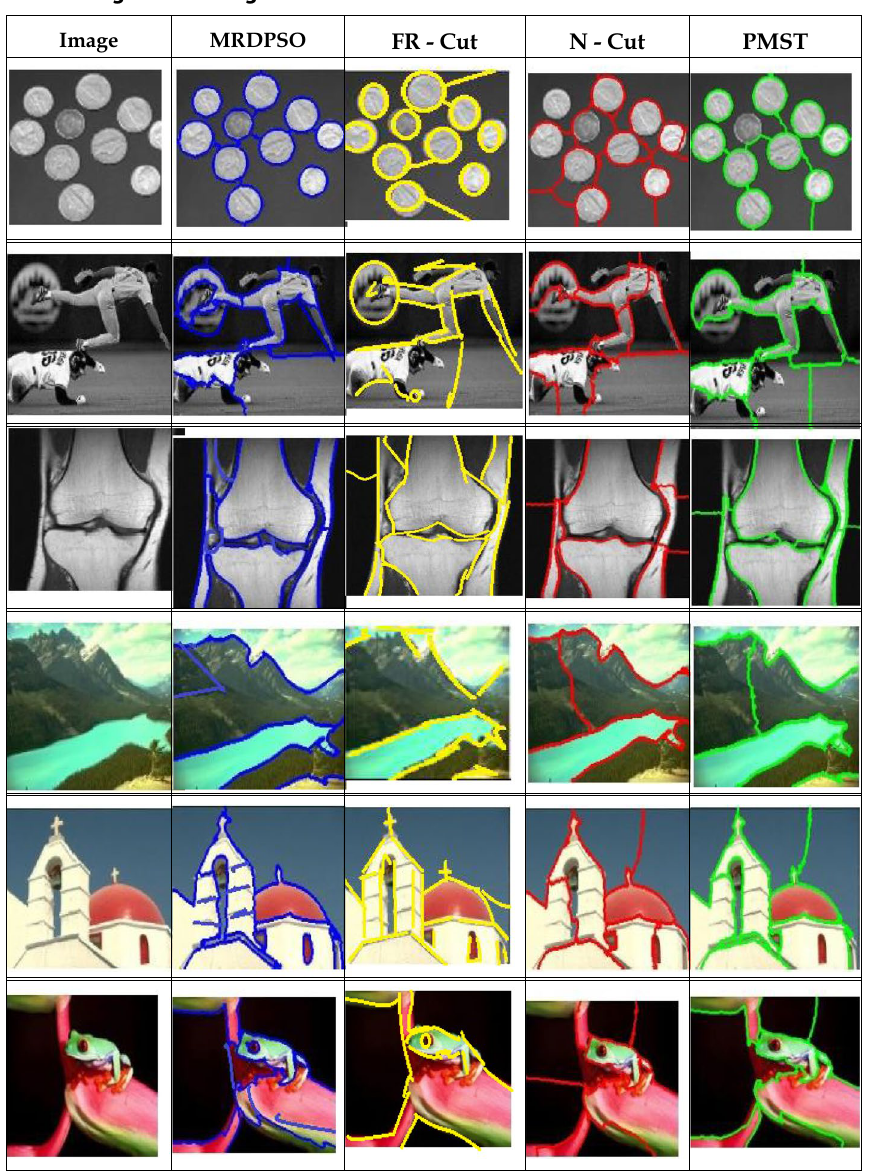
Table 1 Segmented